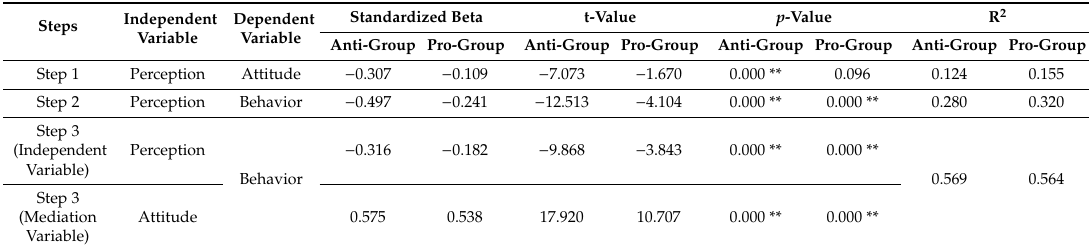
Table 7. High-involvement models for the anti-group and pro-group for reducing nuclear